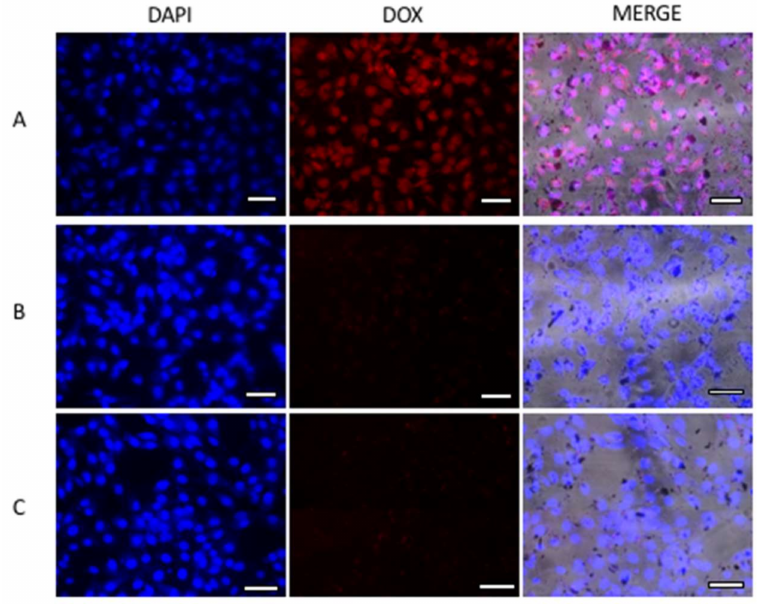
Figure 8. CLSM optical images of MDA-MB 231 cancer cells incubated for 6 h with: ( A ) DOX-FA-rGO/ZnS:Mn; and ( B ) DOX-rGO-ZnS:Mn; ( C ) CLSM optical images of NIH-3T3 cells incubated with DOX-FA-rGO/ZnS:Mn for 6 h. Scale bar = 20 µ